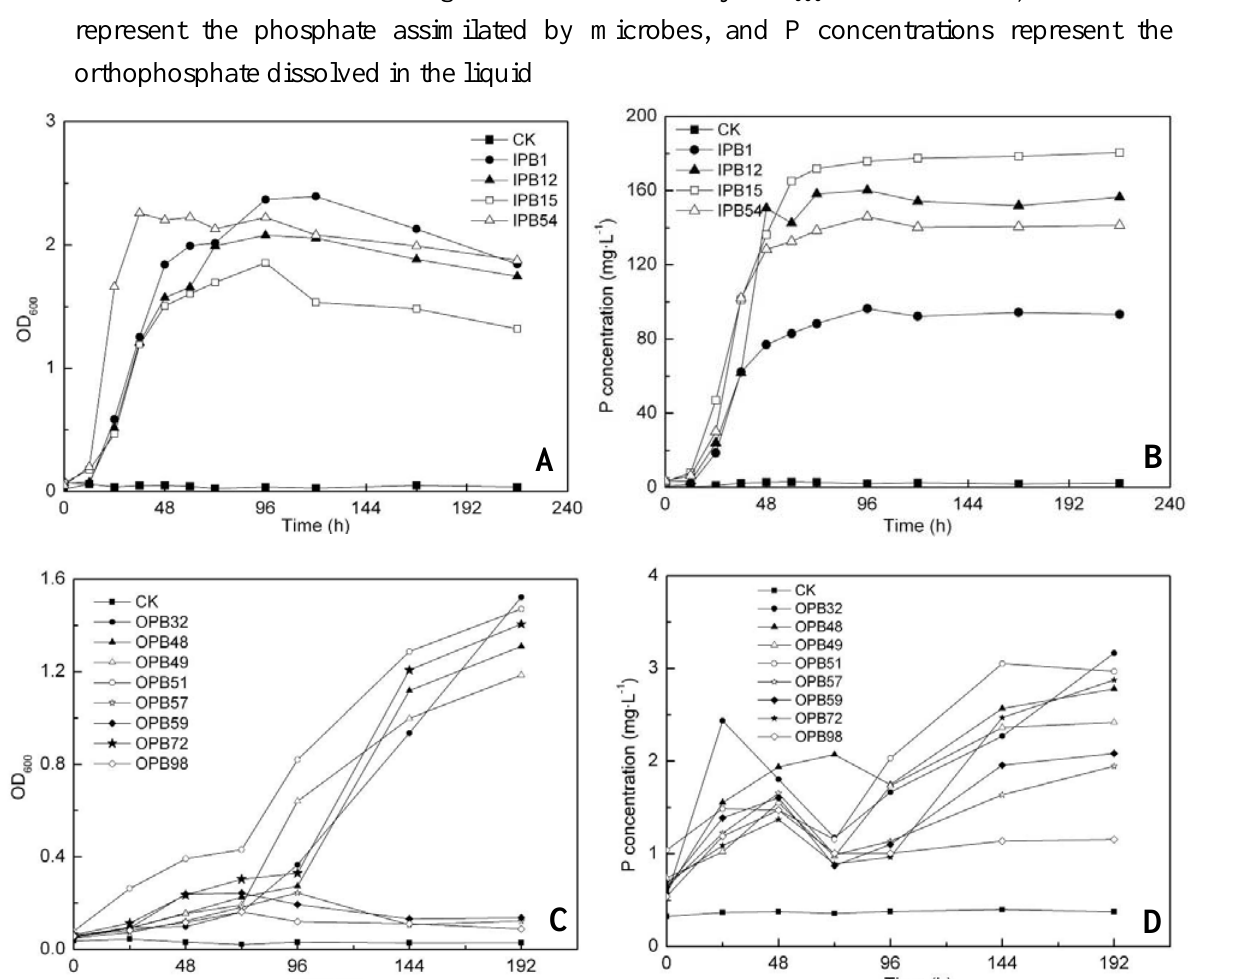
of the culture, which also 600